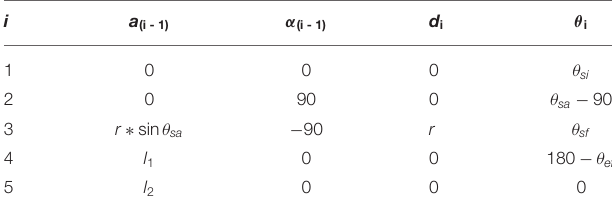
TABLE 2 | Denavit-Hartenberg (D-H)